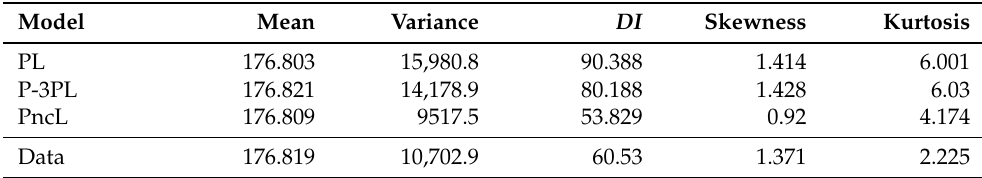
Table 7. Mean, variance, DI , skewness, and kurtosis values of considered discrete models for the guinea pigs